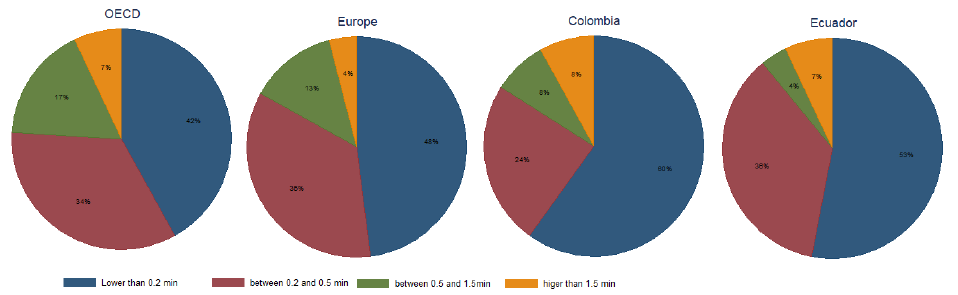
Figure 4: Ecuadorian Urban Primacy Structure (average of all censuses)